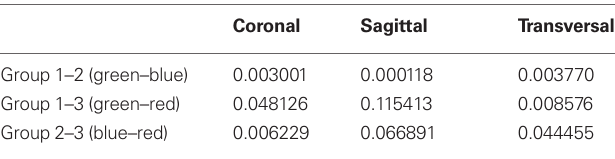
Table 5 | Significance levels for 2D K–S test applied on types of points as defined by the AVPSD method (data from both monkeys